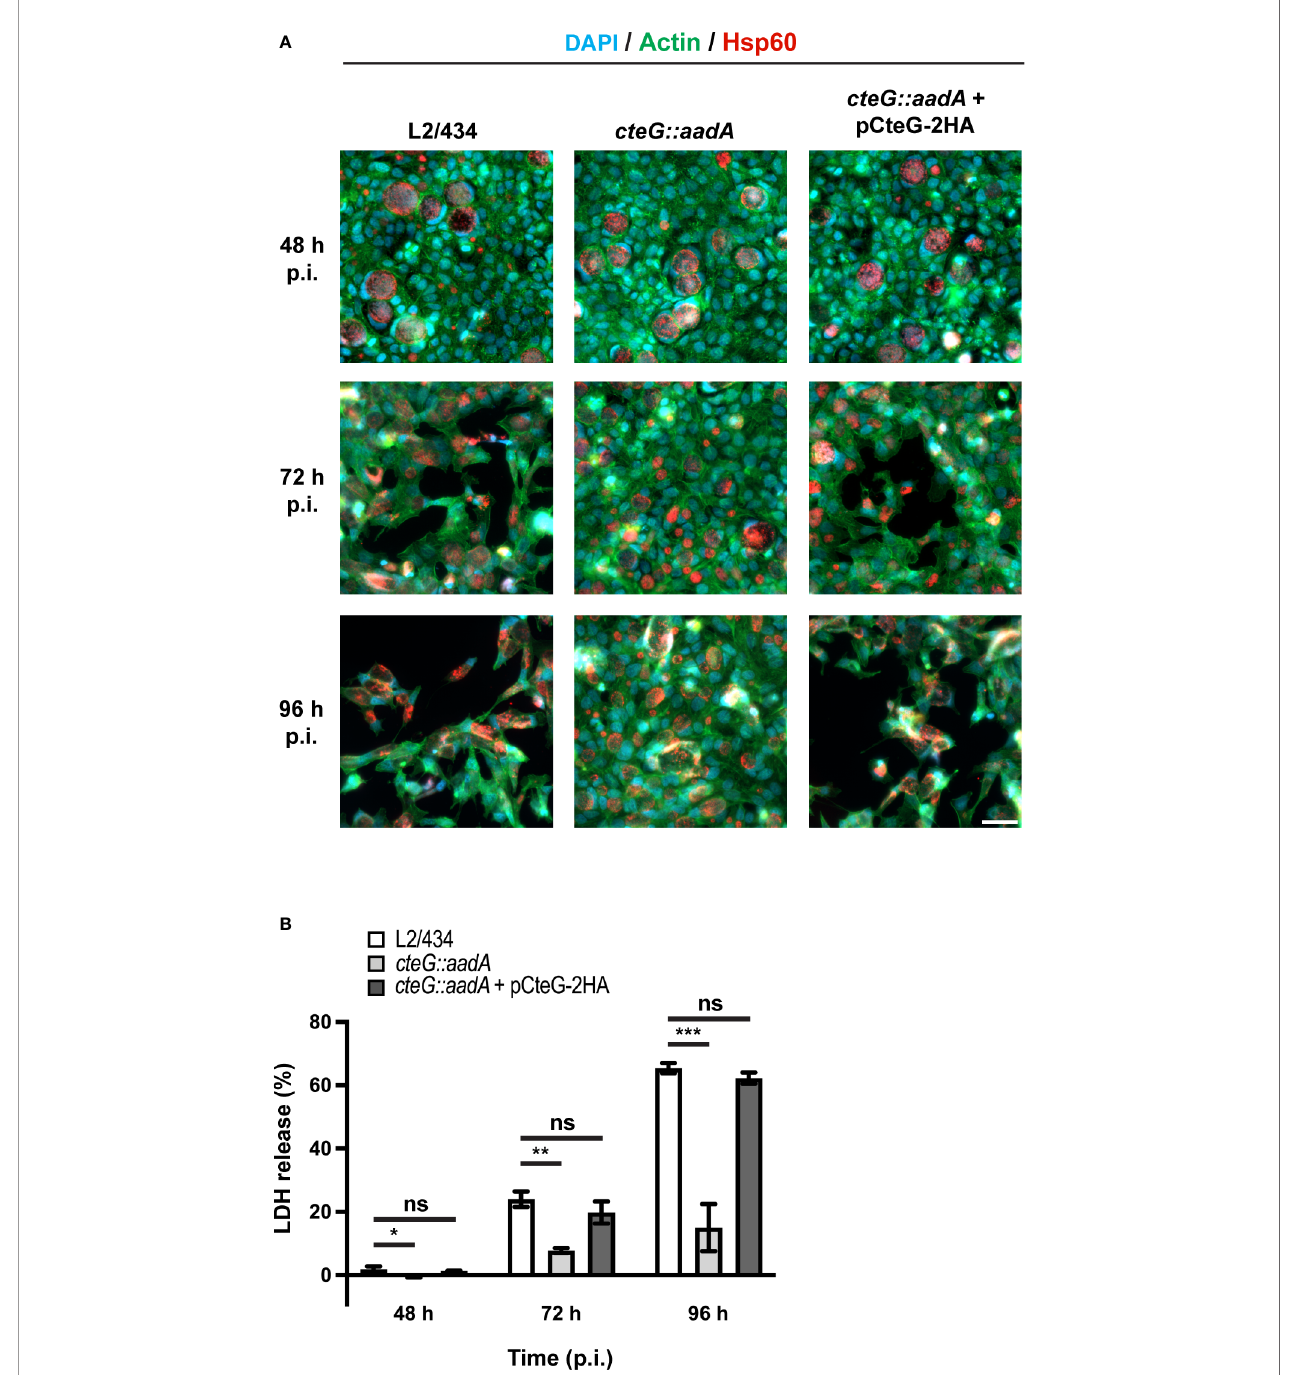
FIGURE 3 | C. trachomatis displays a CteG-dependent defect in host cell lysis. HeLa 229 cells were infected with C. trachomatis parental (L2/434), mutant ( cteG:: aadA ), and complemented ( cteG::aadA harboring a plasmid encoding CteG-2HA; also named pCteG-2HA[Pgp4 + ] in Table 1 and in Figures 4 , 5 ) strains at a MOI of 0.3. (A) At 48, 72 or 96 h post-infection (p.i.), cells were fi xed with methanol, immunolabelled with antibodies against C. trachomatis Hsp60 (red) and appropriate fl uorophore-conjugated secondary antibodies, and stained with DAPI (host cell nuclei and chlamydial inclusions; blue) and with fl uorophore-conjugated phalloidin (host actin cytoskeleton; green). Scale bar, 40 µm. (B) At 48, 72, and 96 h p.i., the release of host lactate dehydrogenase (LDH) into the supernatant of infected HeLa cells was measured using a CytoScan ™ LDH Cytotoxicity Assay kit (G-Biosciences). Data are representative of fi ve independent experiments and correspond to the mean ± standard error of the mean of three biological replicates. For each time point, statistical signi fi cance was determined by using ordinary one-way ANOVA and Dunnett post-test analysis relative to the L2/434 parental strain (ns, non-signi fi cant; *p<0.05; **p<0.01;